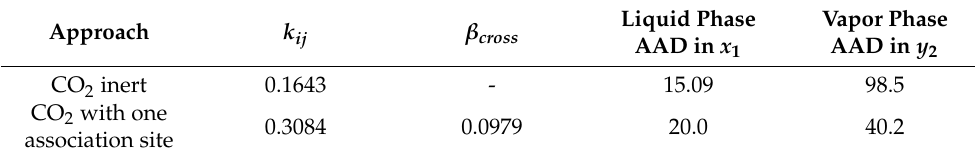
Table 4. Binary parameters and CPA deviations from experimental data [39–42] (296–393 K) for CO